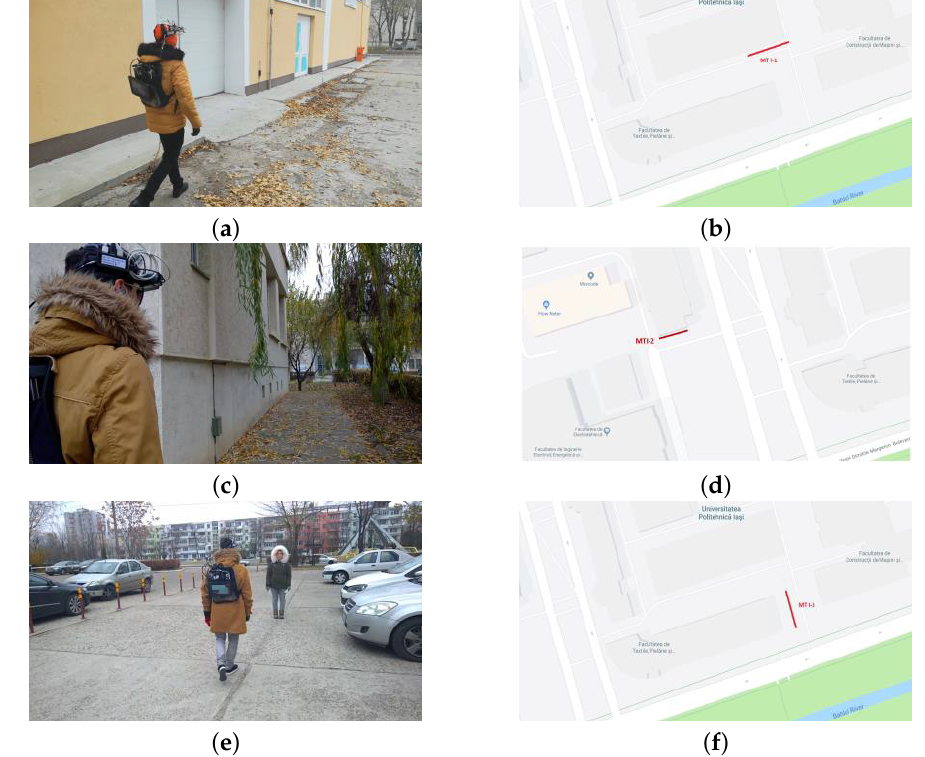
Figure 5. Examples of testing scene set ups for mobility tests in semi-controlled environments: ( a ) Walking by a wall (30 m path), static obstacles on the path (MT I-1); ( b ) Geolocation of MT I-1 testing scenario; ( c ) Walking by a wall (15 m path), hanging obstacles on the path (MT I-2); ( d ) Geolocation of MT I-2 testing scenario; ( e ) Walking in a parking lot (25 m path), parked